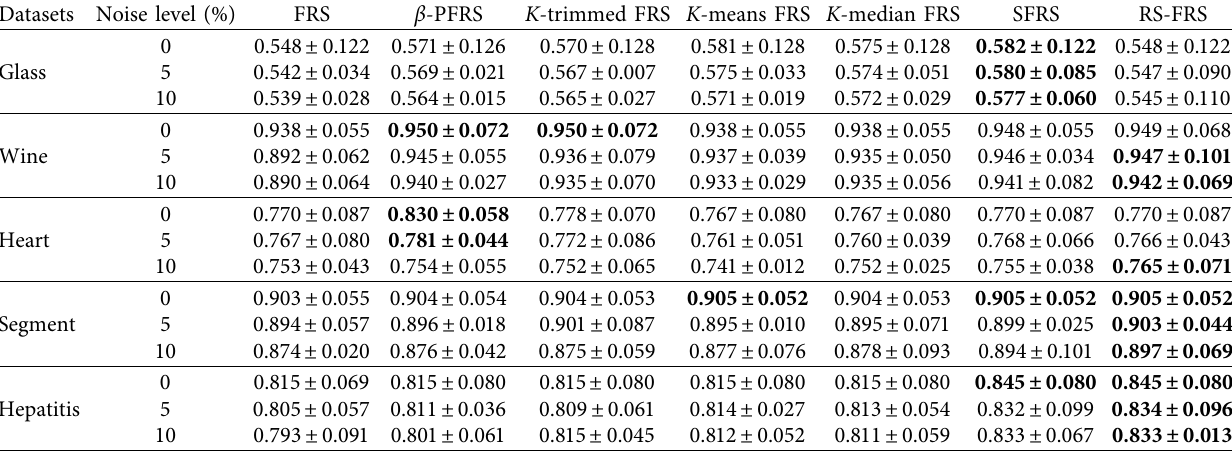
Table 4: Comparison of classification performance of different FRS models on LSVM in original and noisy data. Datasets Noise level